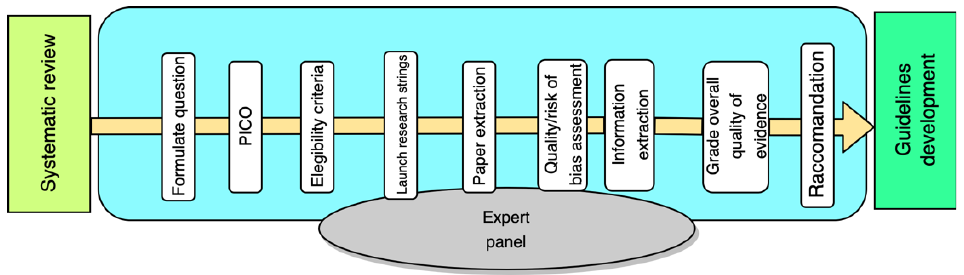
Figure 1. Guidelines development steps, including systematic literature review.